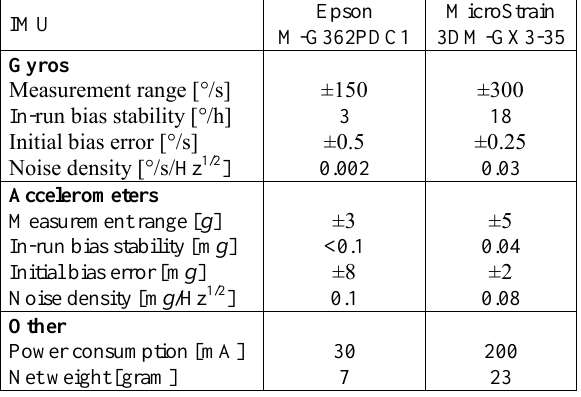
Table 1. Parameters of used IMU sensors